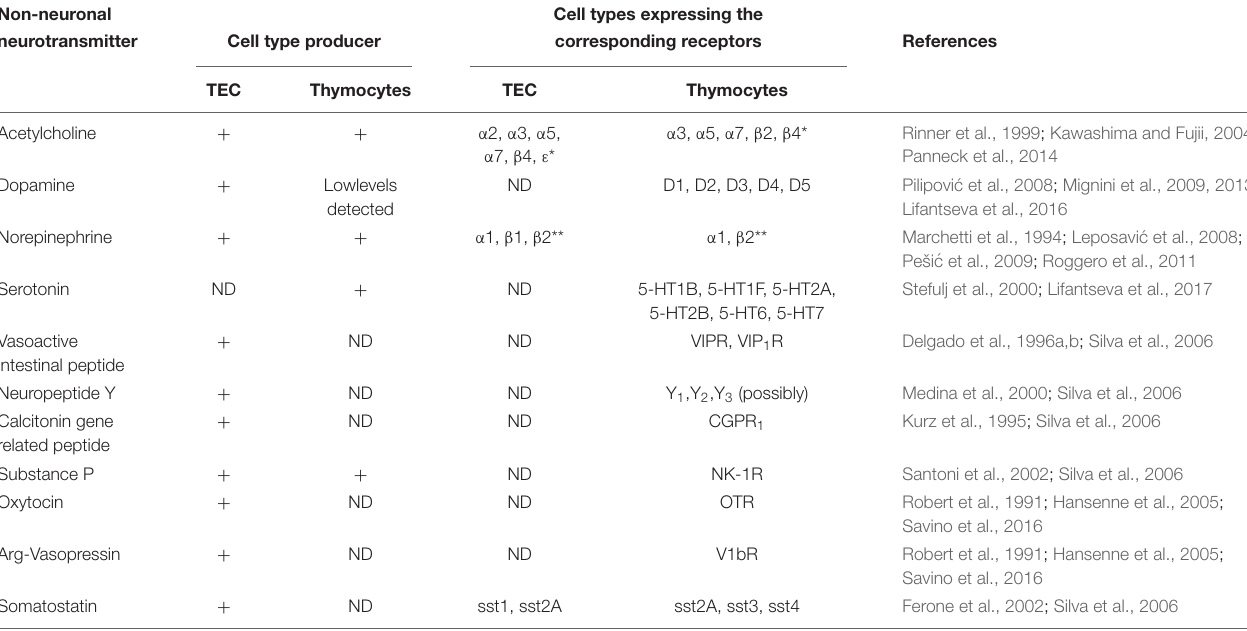
TABLE 1 | Intrathymic expression of non-neuronal neurotransmitters and their corresponding receptors. Non-neuronal Cell types expressing the neurotransmitter Cell type producer corresponding